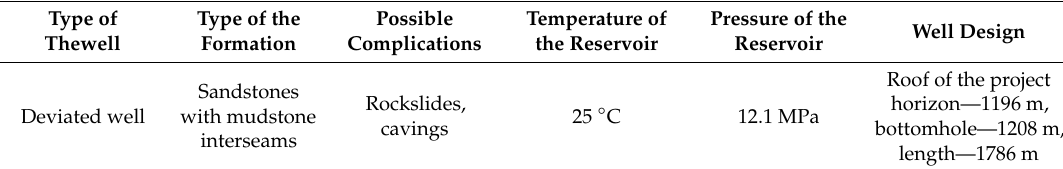
Table 2. Properties of the experimental